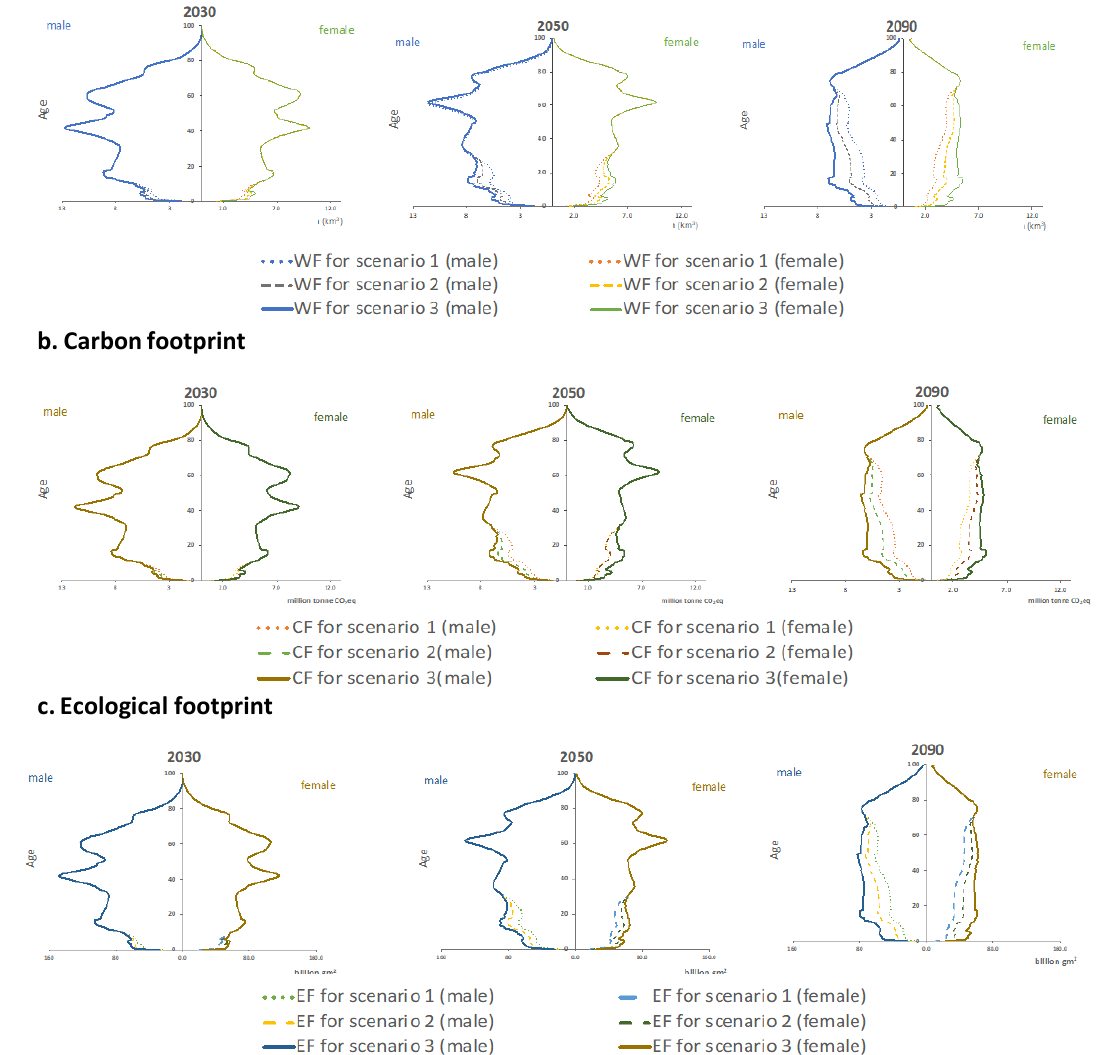
Figure 7. Environmental footprint pyramids demonstrate the changes in the water footprint ( a ), carbon footprint ( b ) and ecological footprint ( c ) under the threepopulation scenarios in 2030, 2050, and 2090 .